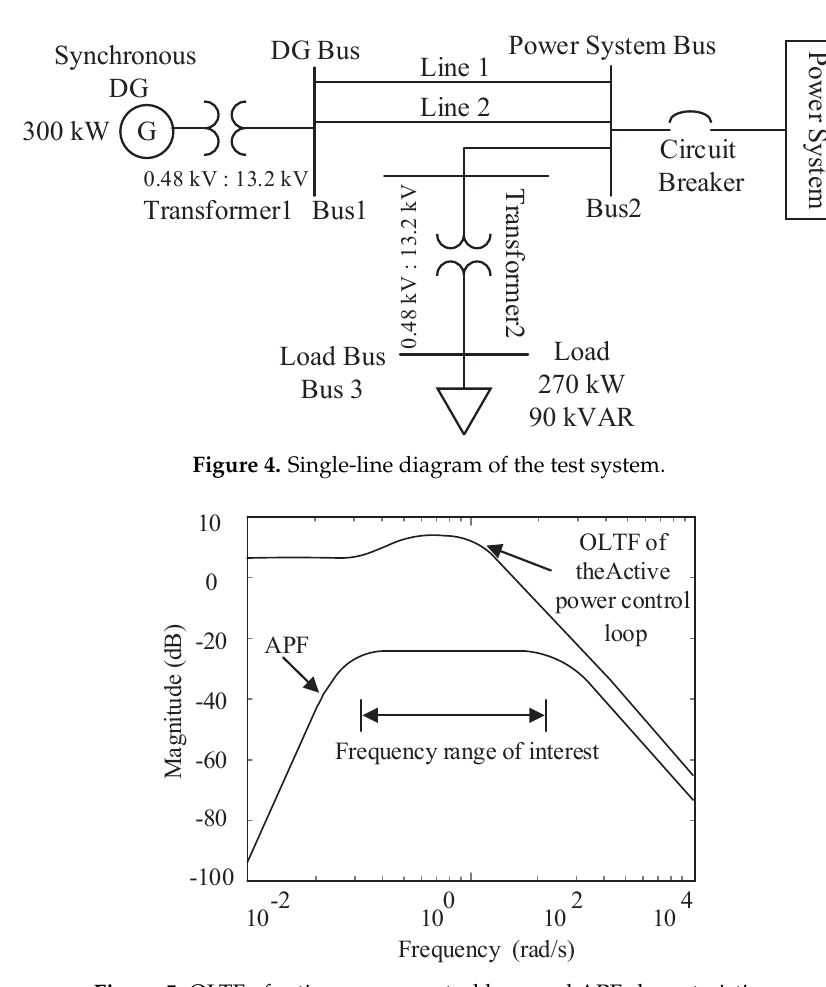
Figure 5. OLTF of active power control loop and APF